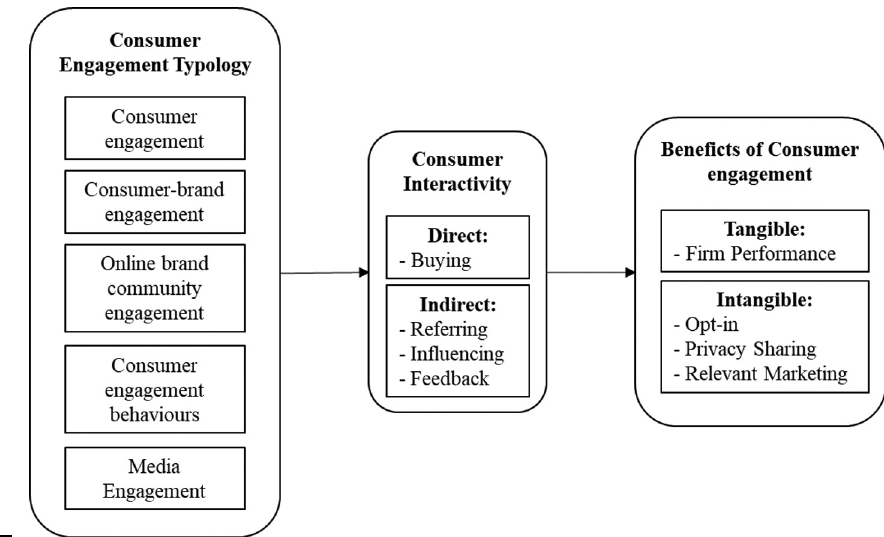
Figure 3. Framework for